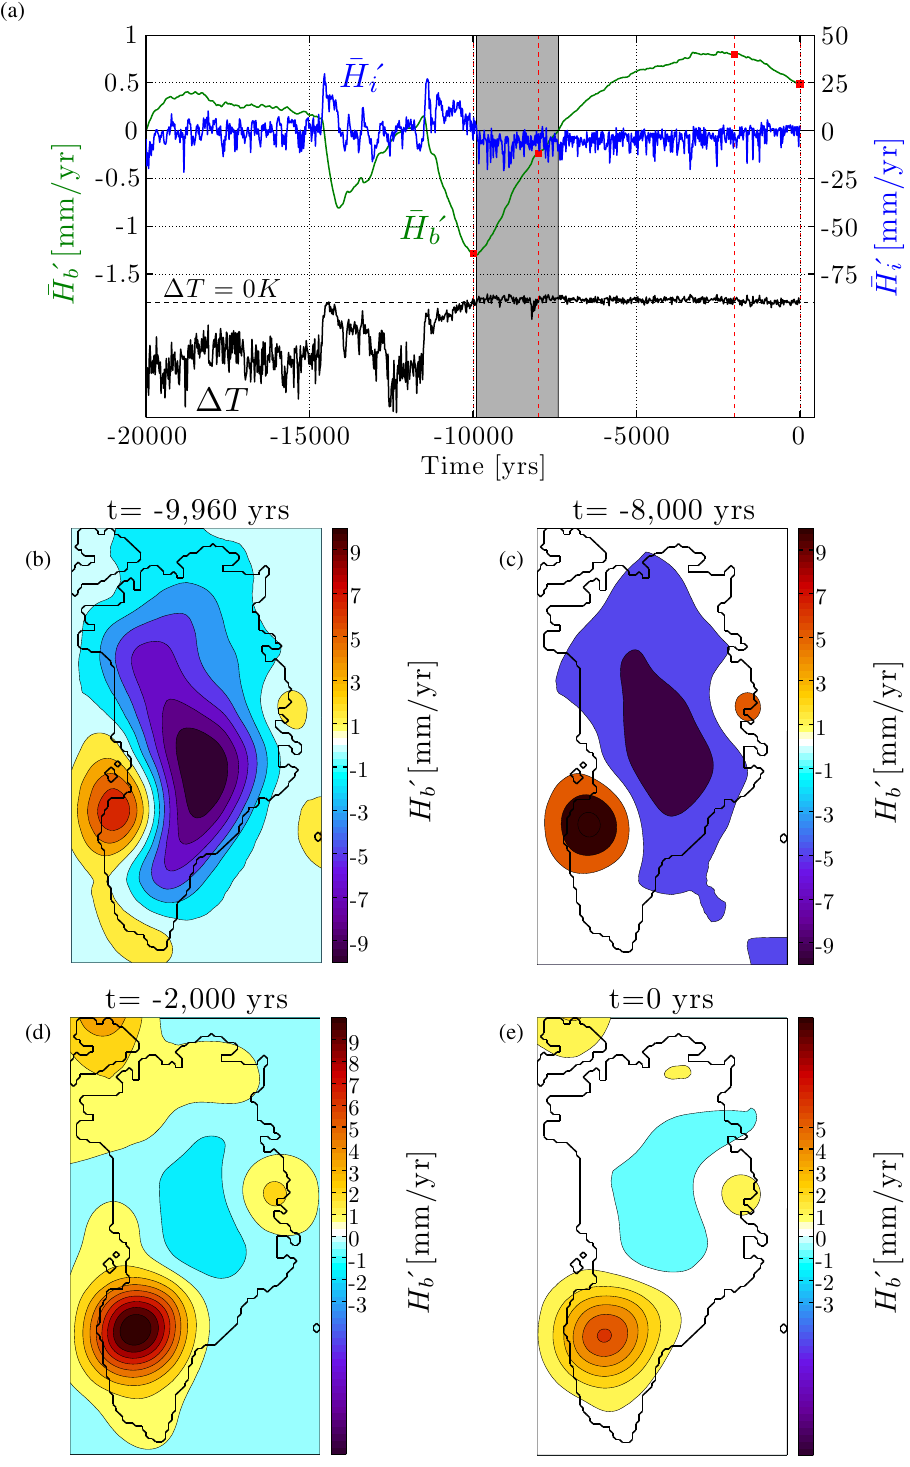
Fig. 4. (a) Time evolution of the spatial average ¯ H 0 (blue line) and ¯ H 0 (green line) for a temperature forcing from ice core data (black line). b i The grey rectangle shows the lag of the bedrock response of 2800yr. (b–e) Spatial patterns of bedrock elevation for the selected red points Fig. 4. a) Time evolution of the spatial average ¯ H 0 (blue line) and ¯ H 0 i (green line) for a temperature forcing from ice core data (black line). b for ( b) the maximum subsidence, (c) a moment when ice thinning and bedrock subsidence exist simultaneously, (d) a moment close to the The grey rectangle shows the lag of the bedrock response of 2800 yrs. (b-e) Spatial patterns of bedrock elevation for the selected red points maximum uplift, and (e) present-day conditions, characterized by an average bedrock for( b) the maximum subsidence; (c) a moment when ice thinning and bedrock subsidence exist simultaneously; (d) a moment close to the maximum uplift; (e) present-day conditions, characterized by an average bedrock uplift.